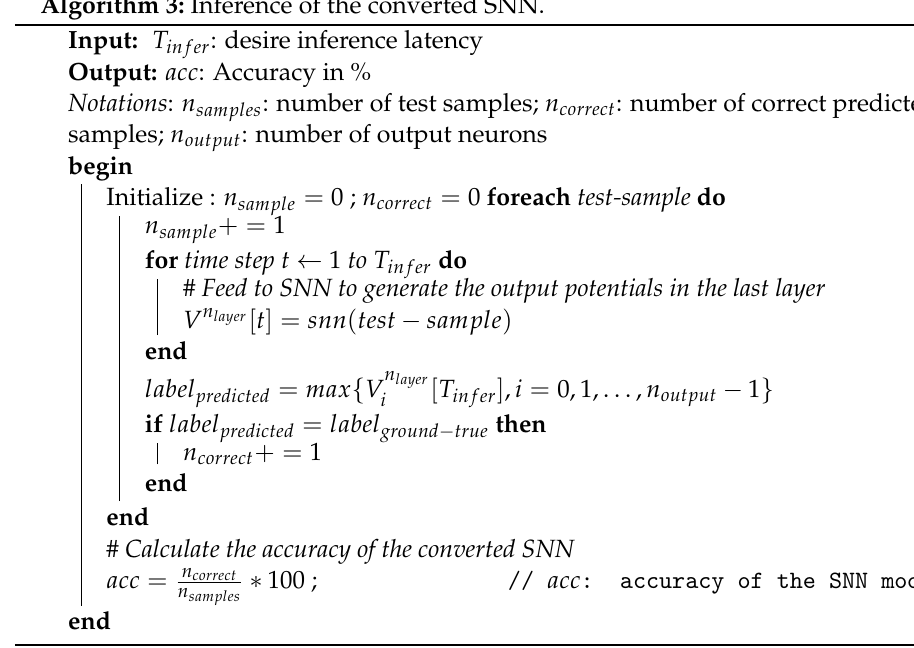
Algorithm 3: Inference of the converted